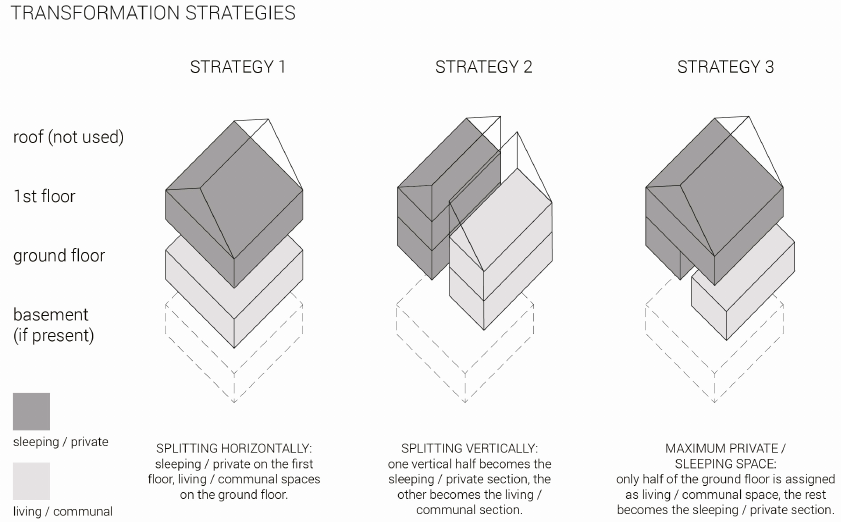
Figure 20. A conceptual representation of strategies 1, 2, and 3 (Ana Bel č i č ,